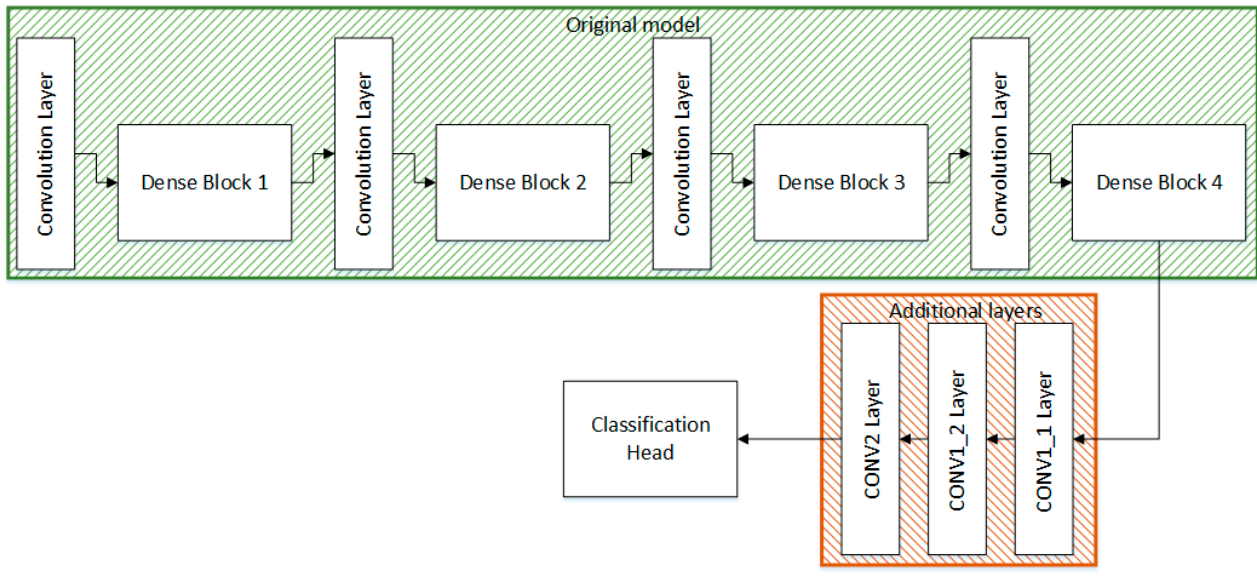
Figure 5. Architecture of the proposed Modified DenseNet201.